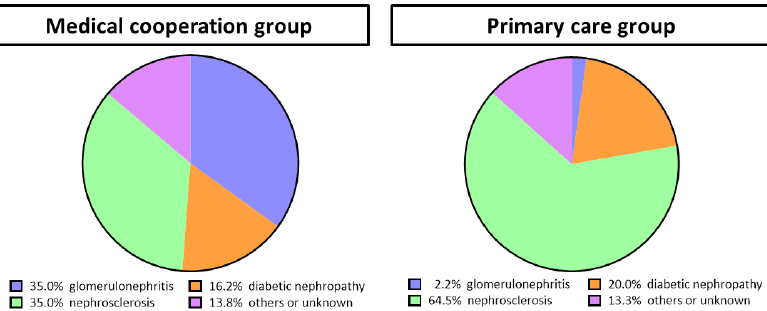
Figure 1. The causes of kidney disease in the medical cooperation group and the primary care group. All patients were classified as one of the following renal diseases based on renal biopsy or clinical diagnosis by the attending physician: glomerulonephritis, diabetic nephropathy, nephrosclerosis, other renal diseases, or unknown. The medical cooperation group tended to have more glomerulonephritis, while the primary care group tended to have more nephrosclerosis.